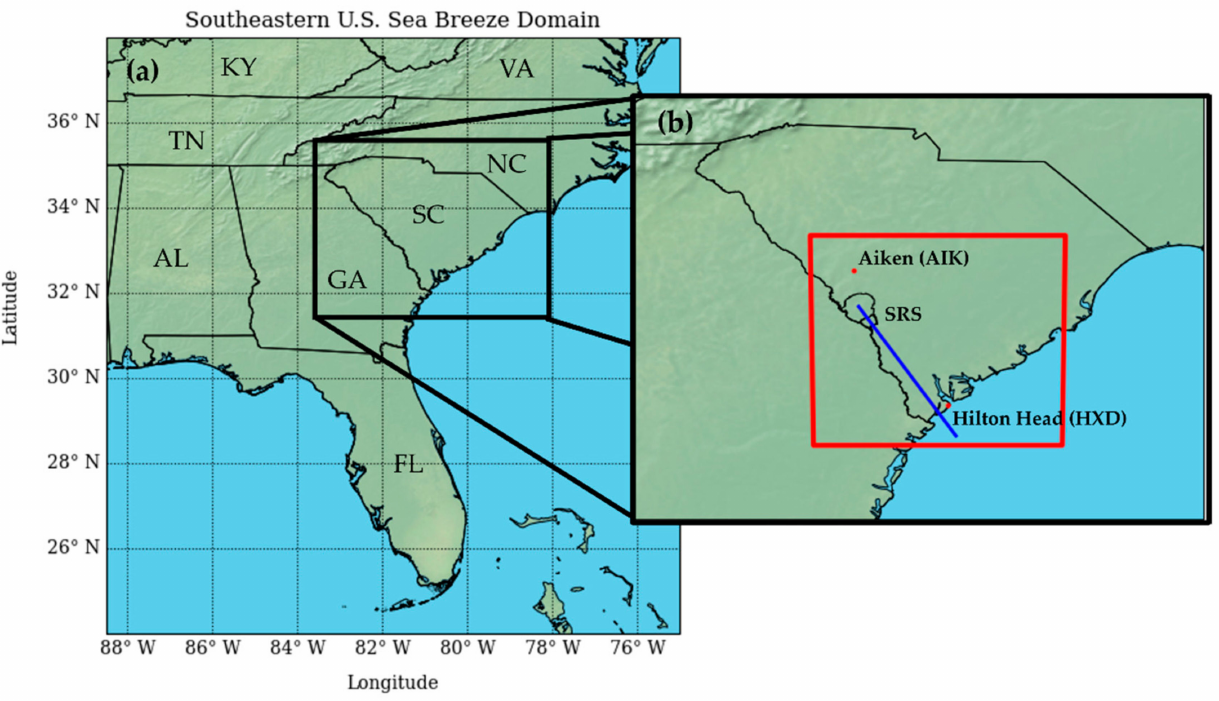
Figure 1. ( a ) A view of the southeastern U.S. (SEUS) with each U.S. state labelled with its two-letter abbreviation. ( b ) A zoomed-in view of the Georgia/South Carolina region that frequently experiences sea breezes in the SEUS. The region on the South Carolina/Georgia border is the Savannah River Site (SRS). The red outline denotes the domain used for the WRF model in this study, with analyses featuring cross-sections along the blue line. The airport weather stations used for the observational analysis are marked with red circles and labelled on the